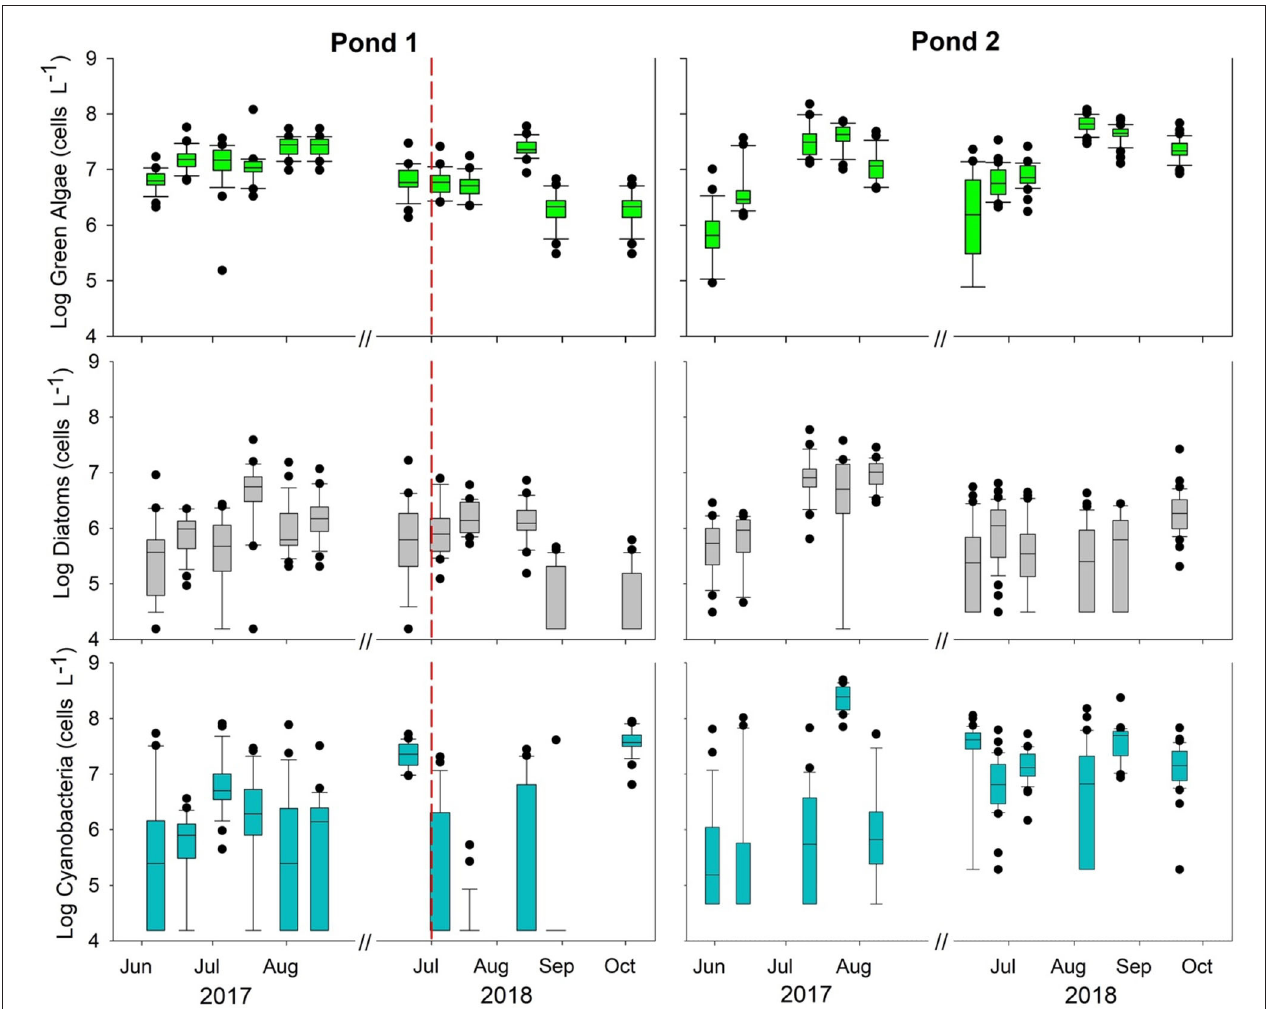
FIGURE 3 | Time series data of log concentrations of the major phytoplankton functional groups (green algae, diatoms, and cyanobacteria) for both years. The mid-point line of the box plots represents the median for each date. Outliers (10 and 90th percentiles) are represented by black circles. The red dashed line represents an algicide application that took place on Jul-1–18 at Pond